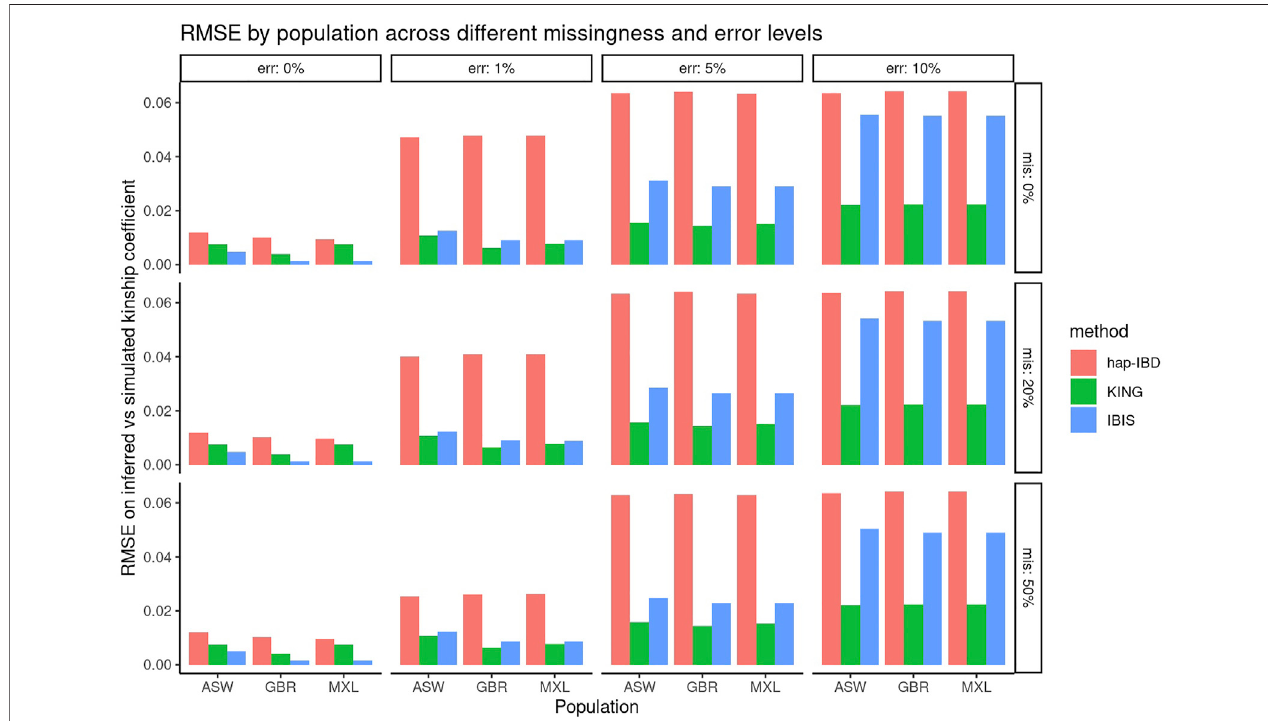
FIGURE2| RMSEcomparingtheinferredversussimulatedkinship.Panelsshowthegenotypingerrorincreasinginpanelsgoingleft-to-rightandmissingdatarates increasing in panels going top-to-bottom. Individual bars within each panel show the classi fi cation accuracy within each simulated population (ASW, GBR, and MXL).